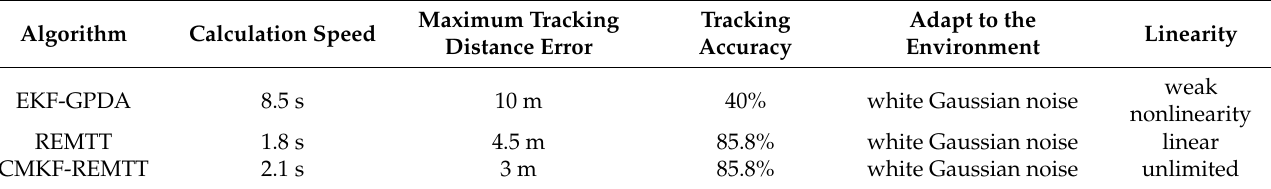
Table 3. Comprehensive comparison of three